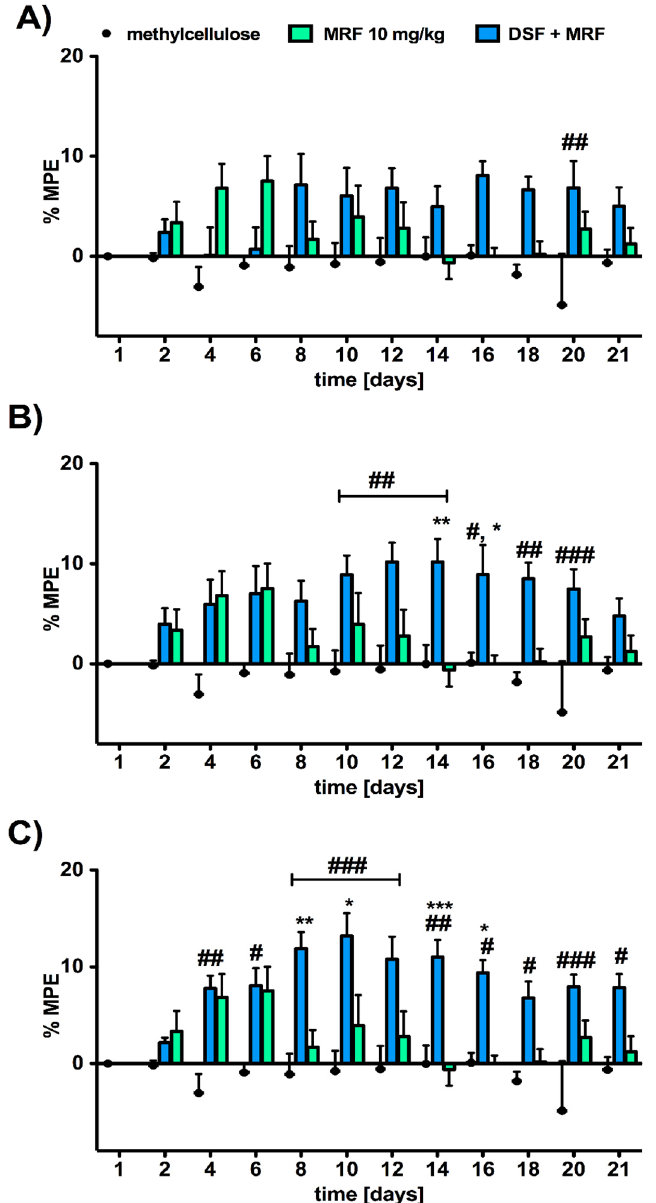
Figure 3. Changes in thermal pain threshold following 21 consecutive days of intraperitoneal co-administration of ( A ) DSF (25 mg/kg) and MRF (10 mg/kg); ( B ) DSF (50 mg/kg) and MRF (10 mg/kg); and ( C ) DSF (100 mg/kg) and MRF (10 mg/kg), assessed in the radiant heat tail-flick test. Analgesic effects were recorded each day, before drugs’ injections. Two-way ANOVA with Bonferroni’s post hoc test was used to determine differences between treatment groups at each time point (days). * p < 0.05, ** p < 0.01, and *** p < 0.001 indicate a significant difference compared with MRF; # p < 0.05, ## p < 0.01, and ### p < 0.001 vs. vehicle-treated animals; n = 9 or 10 animals (male Wistar rats)/group.